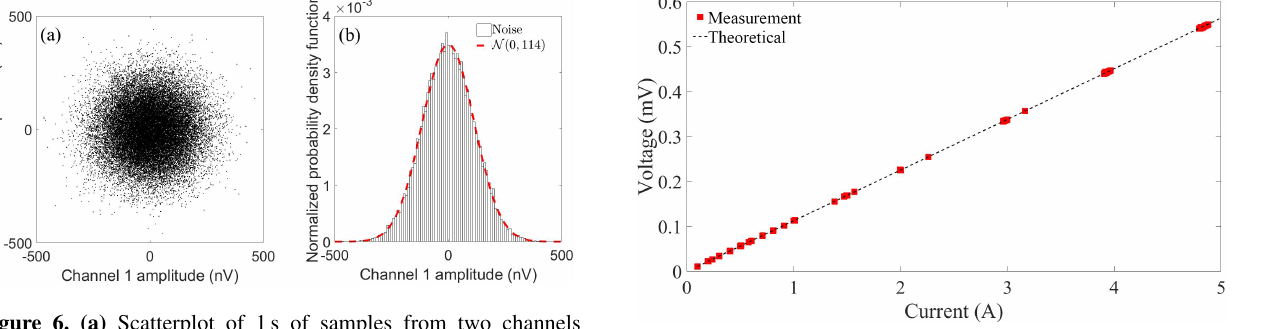
Figure 7. Comparison between measured (red squares) and theoret- ical (black line) signal amplitudes from a magnetic dipole